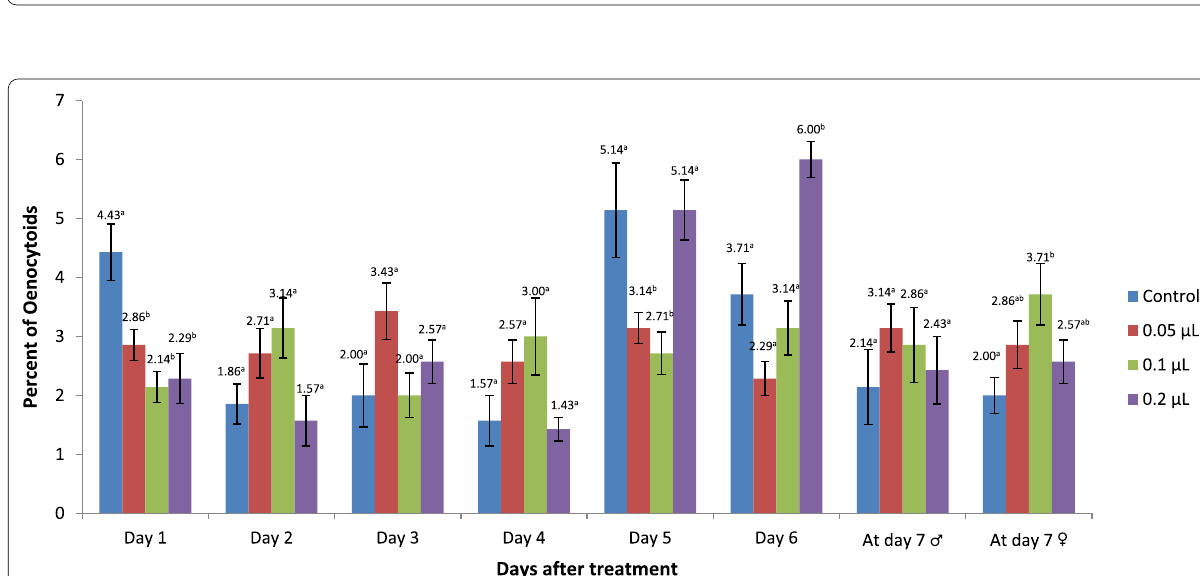
Fig. 5 Effect of Farnesol on Granulocytes of fifth instar nymphs of Dysdercus koenigii. Each bar represents Mean for calculation of mean Bars on a specific day after treatment with different letter are significantly different ( p < 0.05), computed by one-way ANOVA followed by Tukey’s all pairwise multiple comparison test